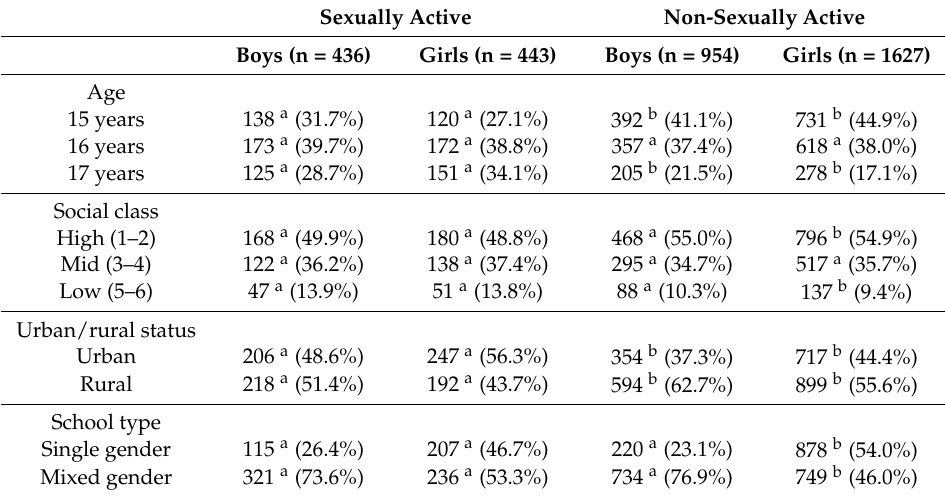
Table 1. Prevalence of socio-demographics among the sexually active and non-sexually initiated samples, by